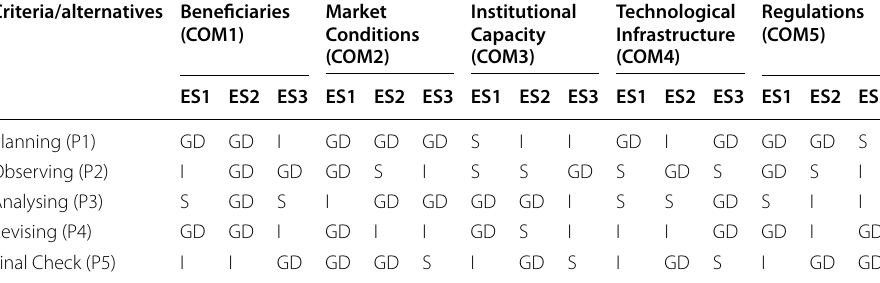
Table 22 LEs for the phase 3 of QFD Criteria/alternatives Beneficiaries